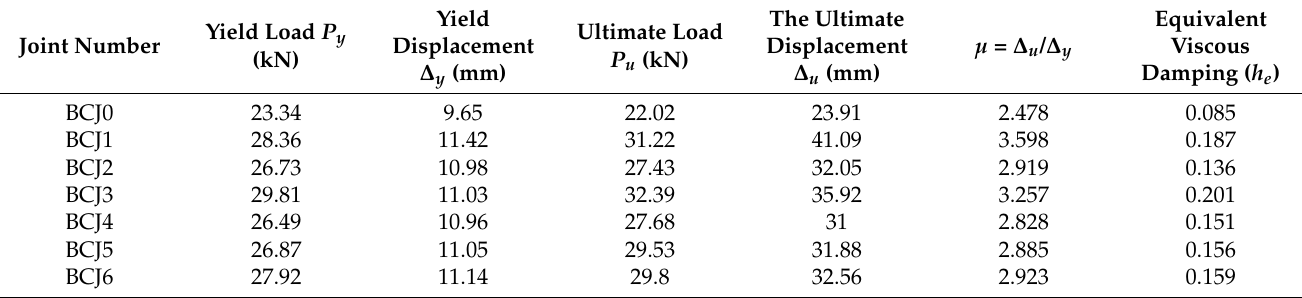
Table 3. Displacement ductility coefficient and energy dissipation coefficient of